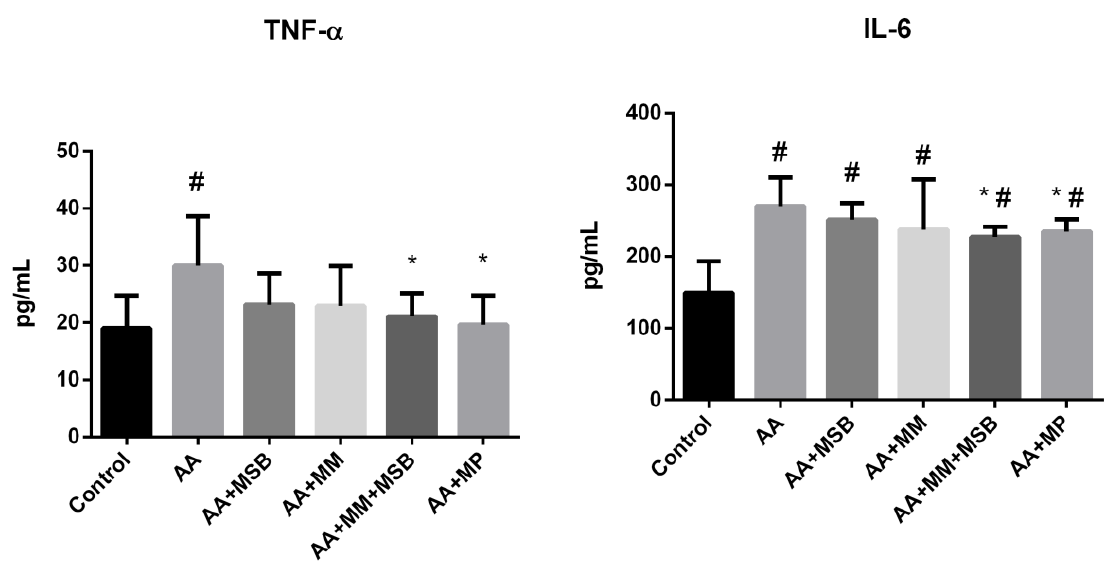
Figure 2. Serum TNF-α and IL-6 levels. * p < 0.05 compared to AA; # p < 0.05 compared to